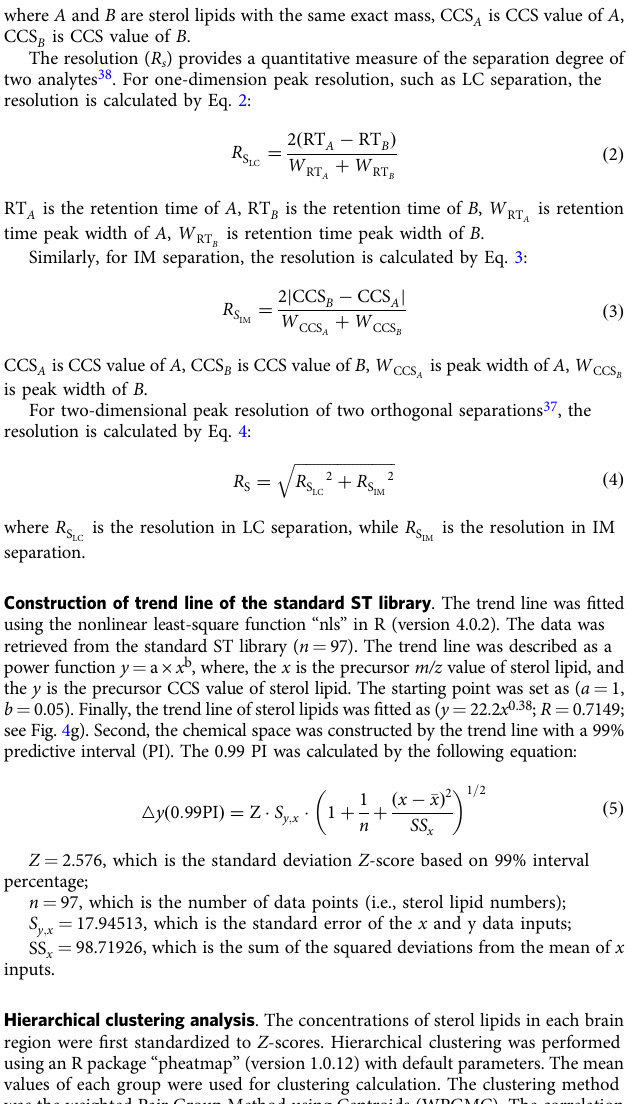
the standard ST library and 2068 sterol lipids in the extended ST library generated in this study is provided in Supplementary Data 3. The sterol identi fi cation and quanti fi cation results generated in this study are provided in Supplementary Data 6 – 8. The interactive mouse brain atlas of sterol lipids is provided on the Brain Sterol Atlas website (http:// mousebrainatlas.zhulab.cn/). The simpli fi ed molecular-input line-entry speci fi cation (SMILES) of 97 sterol lipids were collected from LIPID MAPS Structure